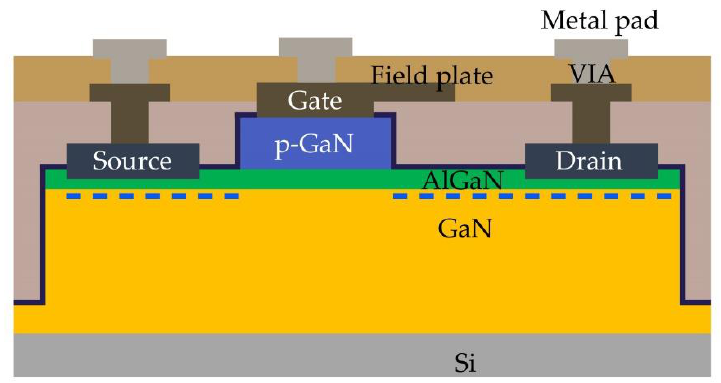
Figure 7. Schematic cross-section for gate structure of a p-GaN HEMT.